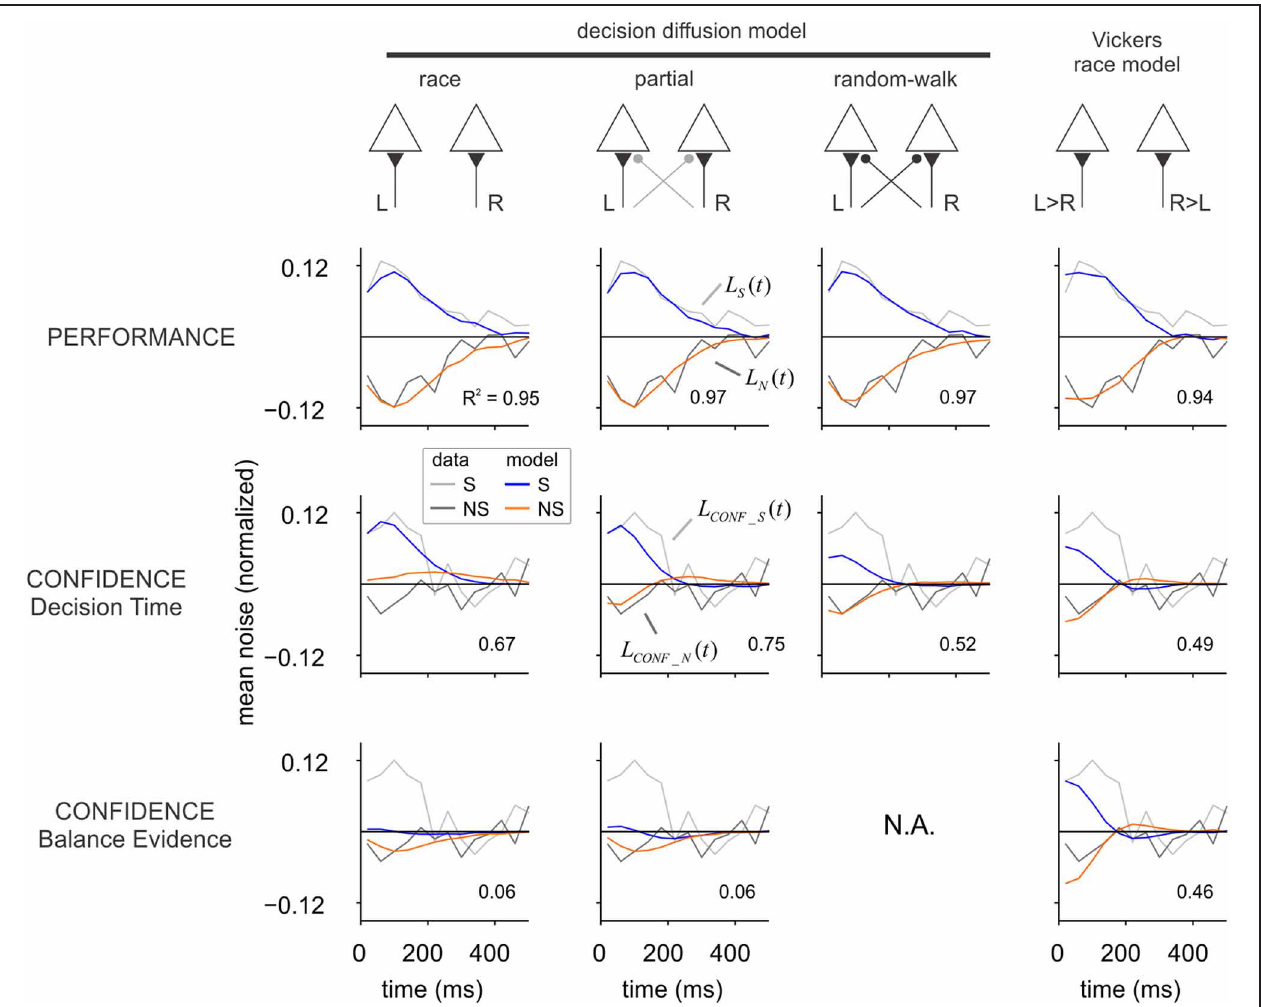
FIGURE 3 | Alternative models of decision and confidence. Each column shows the performance of a different model, sketched in the upper part of the figure. In the race model each signal (L and R) is integrated independently until the first hits a decision boundary. In the random-walk model, it is the difference between both signals (instead of each of them independently) that is integrated to a threshold. In the partial model, evidence for the opposite alternative is integrated but less efficiently. In Vickers race model, the sign of the difference between L and R defines which of the two accumulators is updated in each time step. For each model, we computed the influence of fluctuations on choice and confidence. In the upper row (“Performance”), the average of the input noise to the winning (S) and losing (NS) accumulators is shown in blue and orange, respectively. Gray and black curves show the noise averages from the luminance experiment (repeated from Figure 2C ),